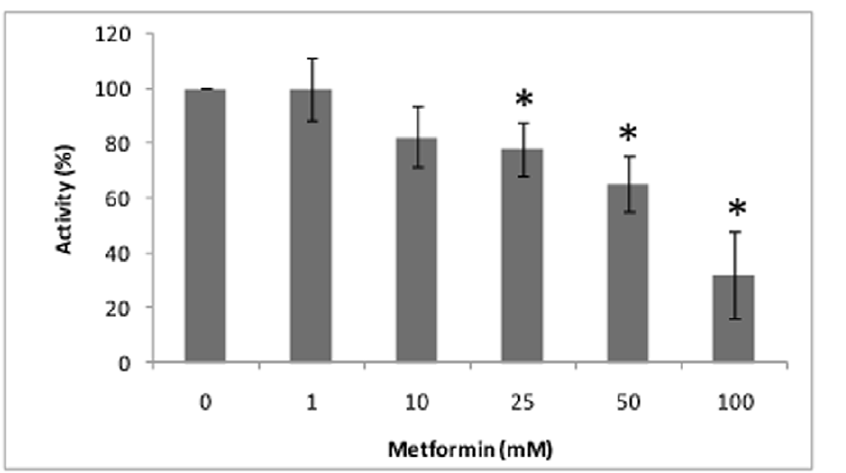
Figure 2. Glutaminase activity in chemical assay (%), according to metformin concentration. Each bar represents the mean 6 SD (all experiments were conducted by triplicate).